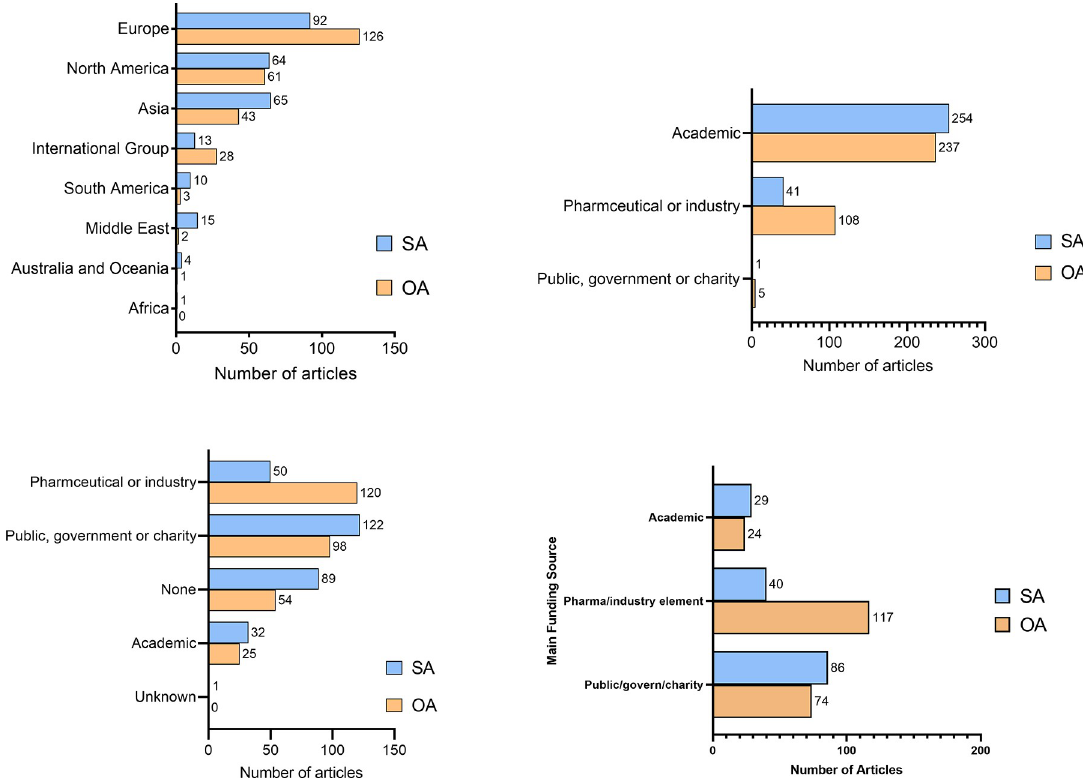
Fig 2. Breakdown of open access (OA) and subscription-based access (SA) articles by a) geographical region of authors, b) author institution type, c) funding source and d) article numbers by funding source.